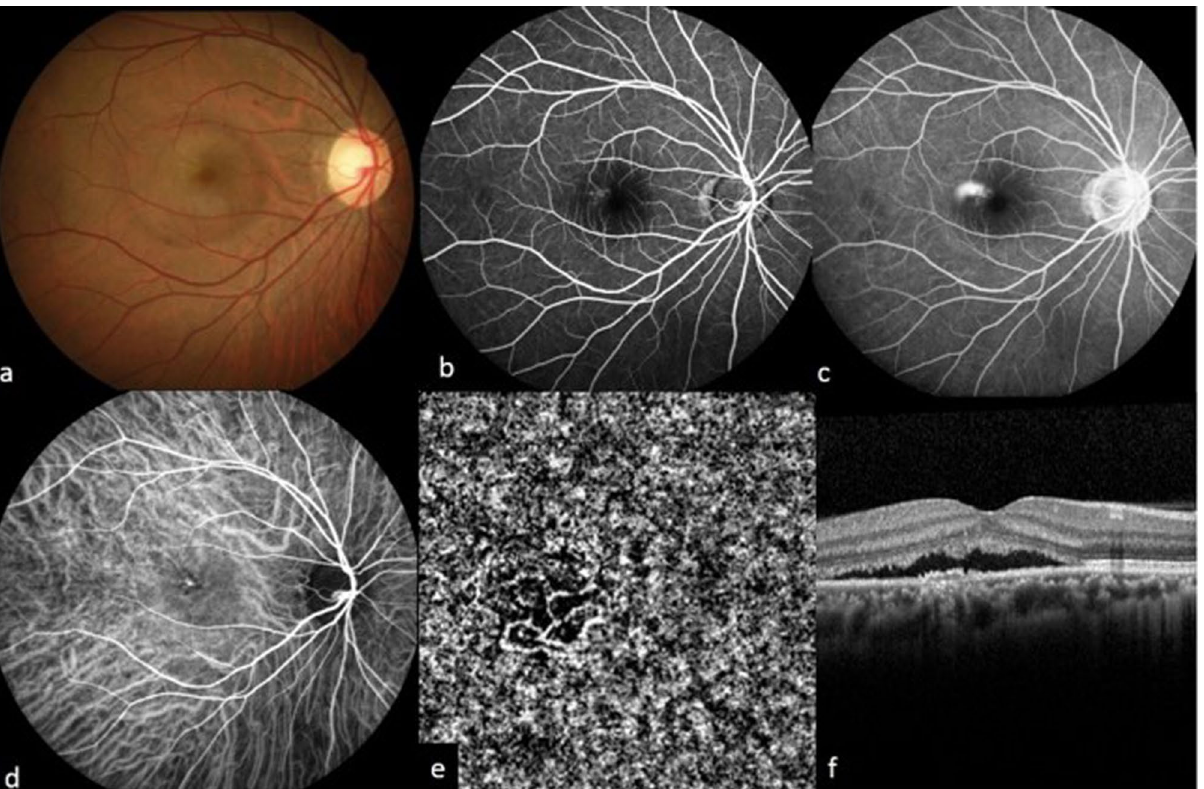
Figure 3. Multimodal imaging of a 45-year old male patient (case 2) in group 1. Fundus photography showed serous detachment at macular area ( a ). Early phase ( b ) and late phase ( c ) fluorescein angiography